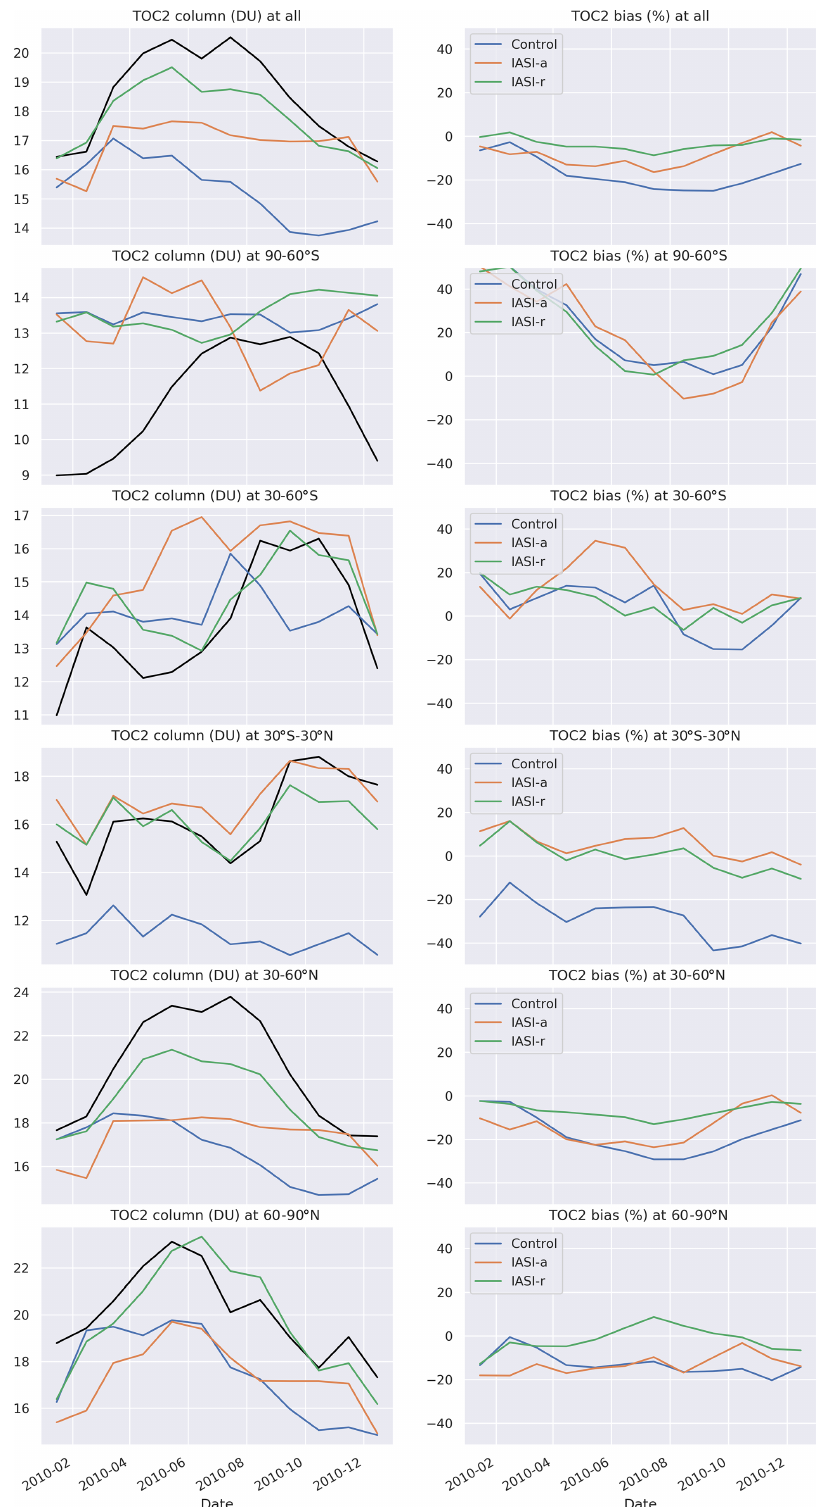
Figure 3. Monthly variability in the ozone free-troposphere column (345–750hPa) averaged globally (top row) and for five respective latitude bands: 90–60 ◦ S, 30–60 ◦ S, 30 ◦ S–30 ◦ N, 30–60 ◦ N, and 60–90 ◦ N (see panel headings). The left column of the figure shows the absolute values of the O 3 columns (in DU) for IASI-a (orange line), IASI-r (green line), the control simulation (blue line), and the corresponding ozonesonde columns (black line). The right column of the figure shows the relative differences between the simulated and corresponding ozonesonde columns (as a percentage of ozonesonde